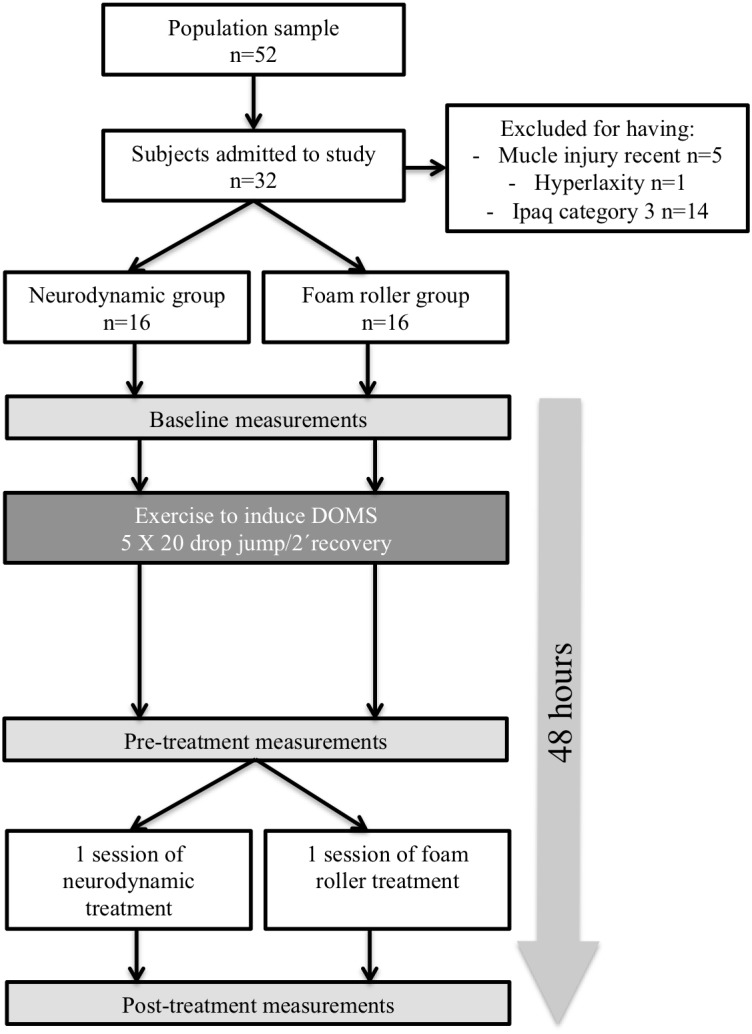
Flow chart of the study design.